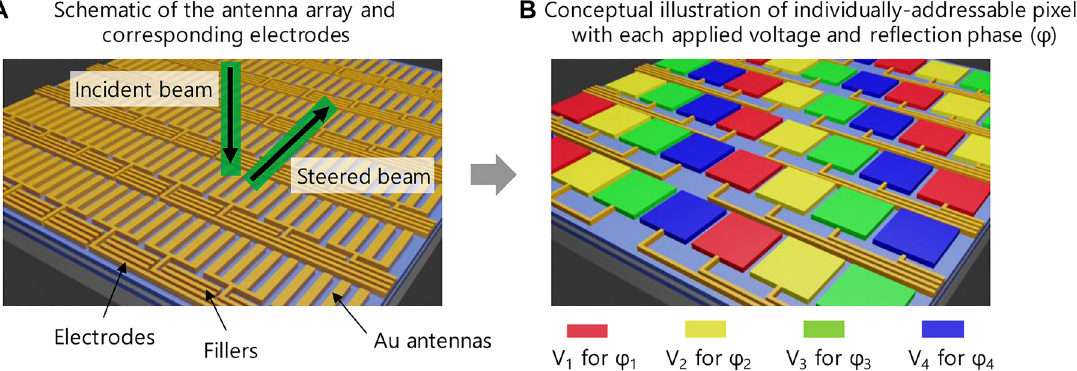
Figure 1: Schematic and conceptual illustration of the metasurface array for two-dimensional beam steering. (A)Schematicoftheantennaarrayincludingtheelectrodesandfillers.Theinfraredincidentbeamilluminatesthedevicefromthetopwiththe electrical field perpendicular to the Au antennas and produces the steered beam to the desired two-dimensional direction depending on the voltage distribution. (B) Corresponding conceptual illustration of the individually-addressable pixels with the colored patches. The colored patchesdonotrepresentthepatchantennaasinRef.[21].Thetopfan-outsconnectedtoeachpixelallowtheseparatedoperationofthepixels for the given